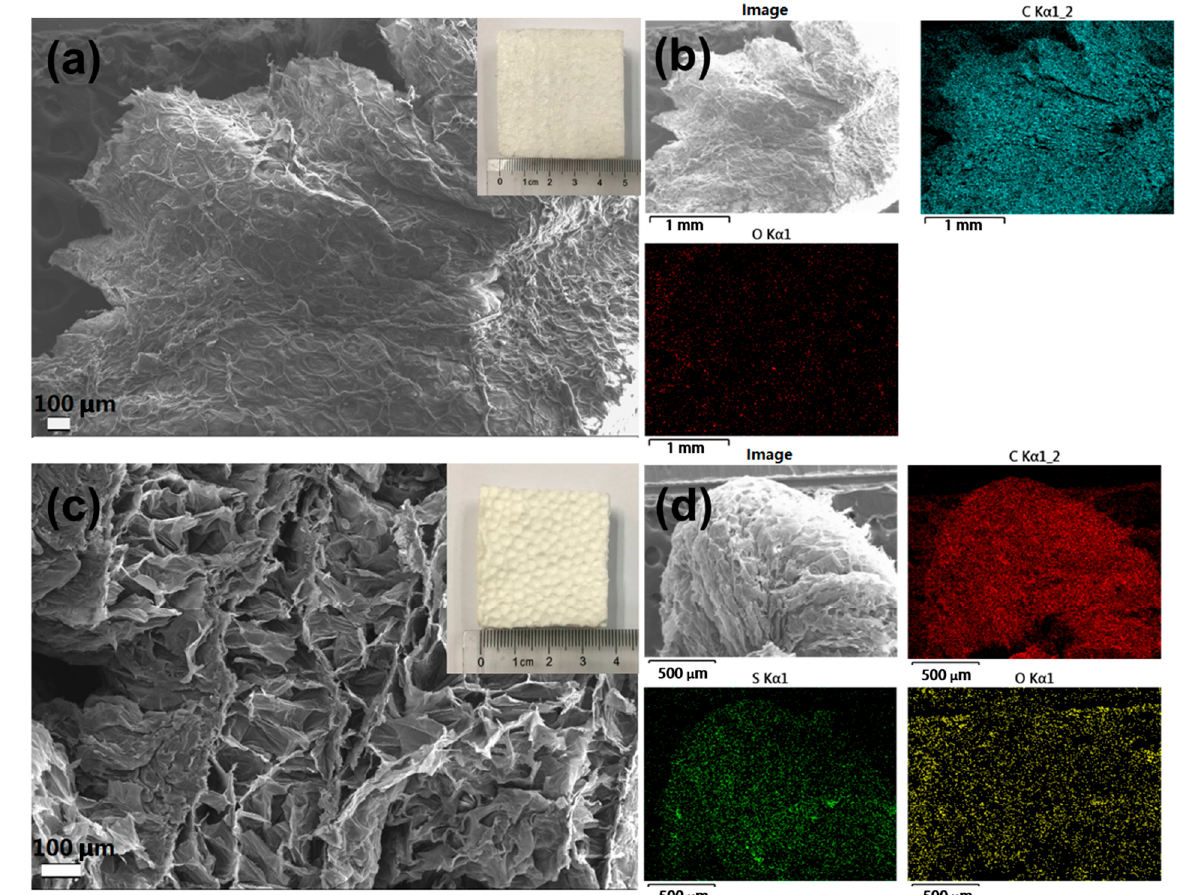
Figure 2. FESEM images of ( a ) pristine EPS and ( c ) SPS foams (the insets in ( a , c ) are the corresponding digital photos of EPS and SPS foams); EDX mapping images of ( b ) pristine EPS and ( d ) SPS foams.